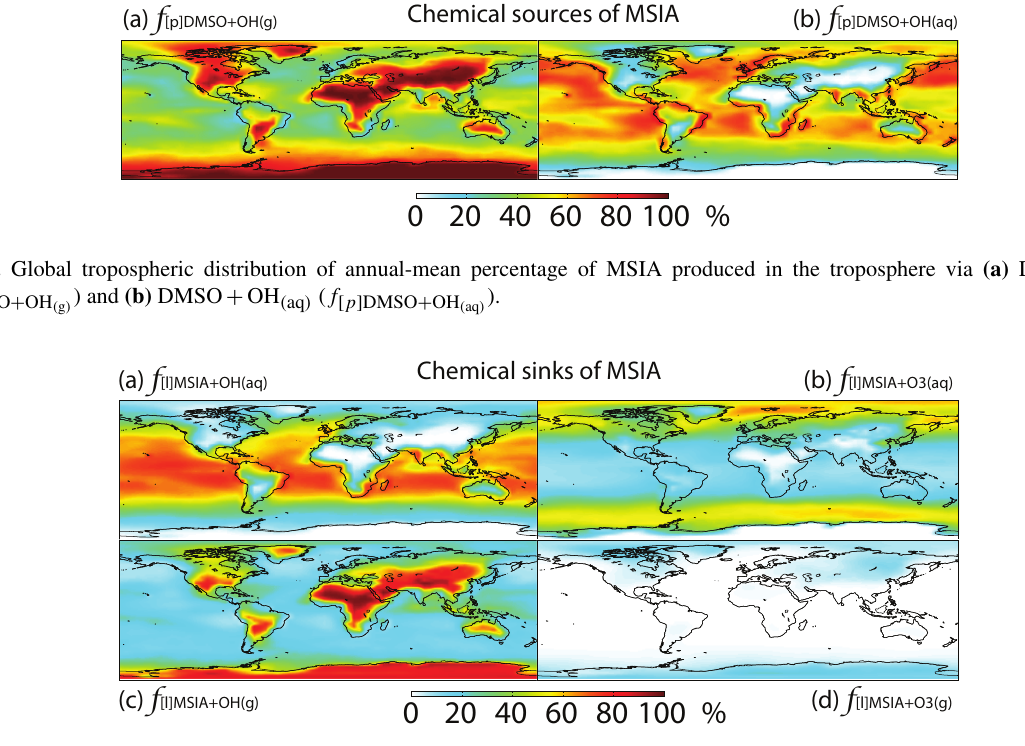
Figure 7. Global tropospheric distribution of annual-mean percentage of MSIA oxidized in the troposphere via (a) MSIA + OH ( aq ) ( f [ l ] MSIA + OH ), (b) MSIA + O 3 ( aq ) ( f [ l ] MSIA + O ( aq )